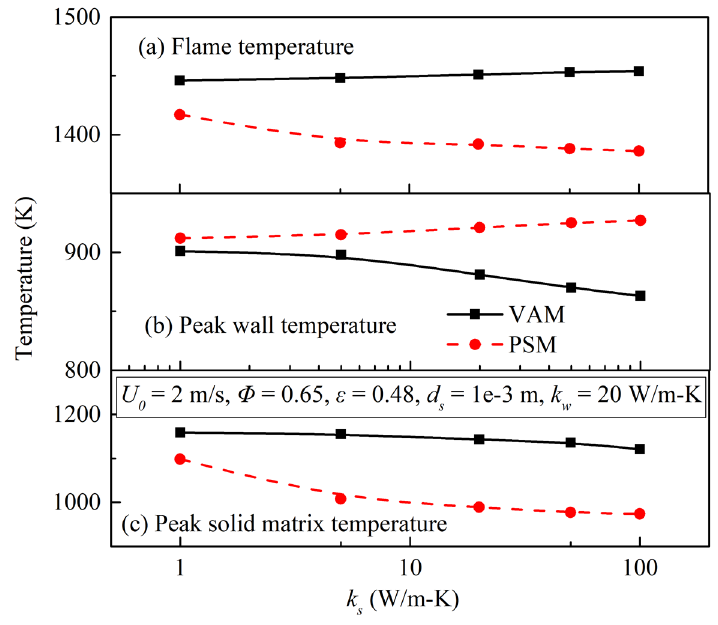
Figure 12. Effects of k s on the temperature obtained by the PSM and VAM.